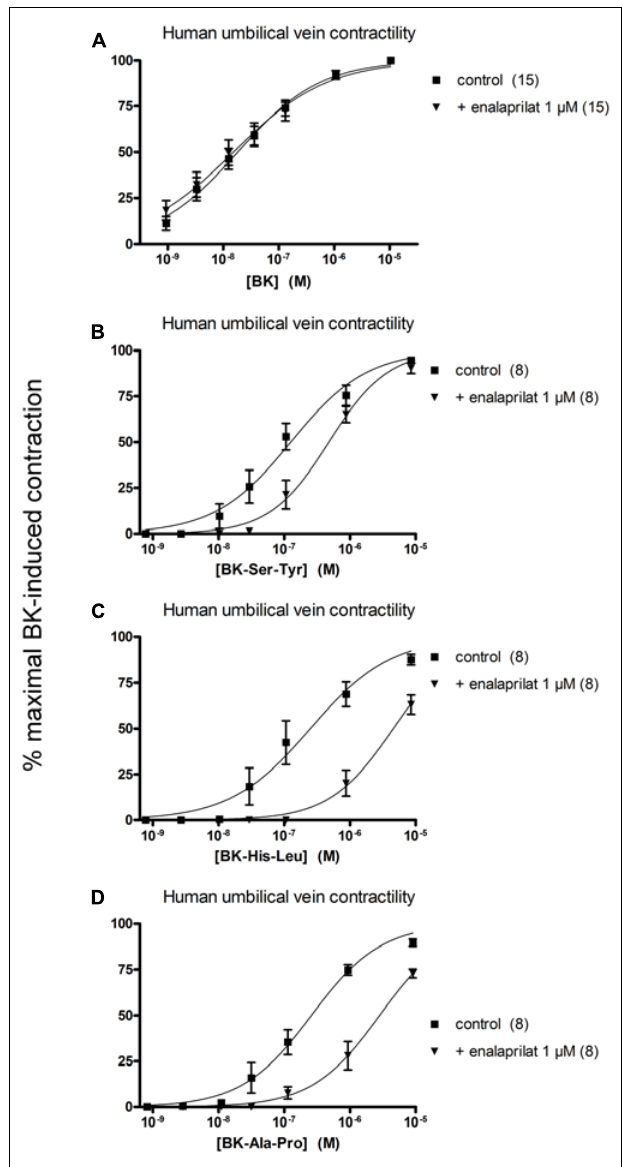
FIGURE 3 | Contractility studies in the human isolated umbilical vein, a bioassay for the B 2 receptors, for BK and three C-terminally extended analogs that are potentialACE substrates. (A) Cumulative concentration-effect curve for BK as modified by the ACE inhibitor enalaprilat (1 μ M). (B,C) Cumulative concentration-effect curve for BK-Ser-Tyr (B), BK-His-Leu (C) and BK-Ala-Pro (D) as modified by the same drug.The control curves were constructed in the presence of the DMSO vehicle of enalaprilat. Separate tissues from the same individuals were used as controls.Values are means ± SE of the number of replicates indicated between